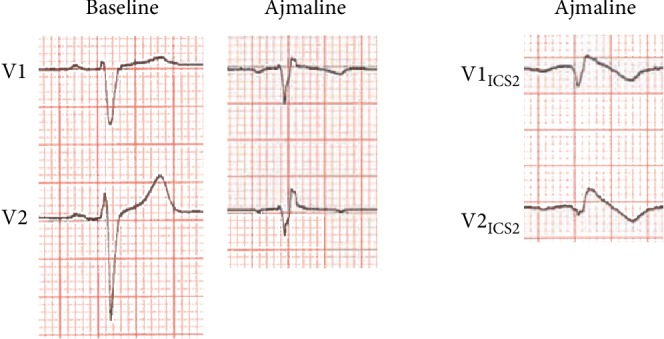
Provocation test with ajmaline elicited a type 1 ECG in the 2nd intercostal space cranially from V1 and V2 (V1ICS2 and V2ICS2).